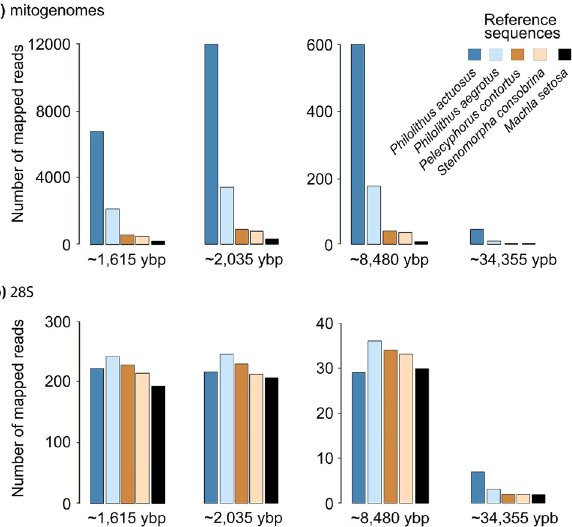
Figure 2. Comparison of the number of successfully recovered mitochondrial ( a ) and nuclear ( b ) reads from the analyzed libraries representing ancient samples mapped to different reference sequences. Subsequent reference sequences represent species increasingly less related to the analyzed ancient species based on morphological